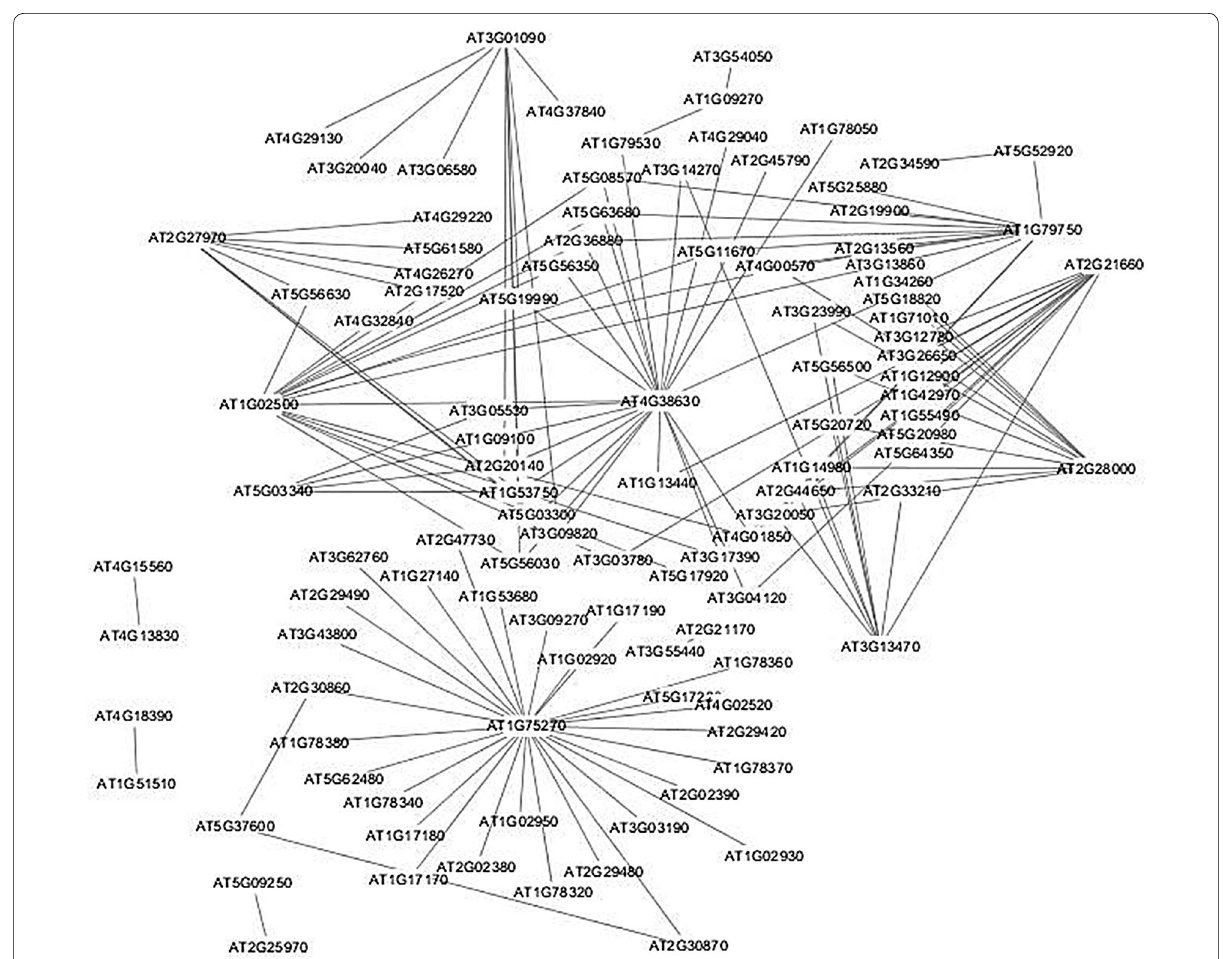
Fig. 2 Protein–protein interaction network of the upregulated